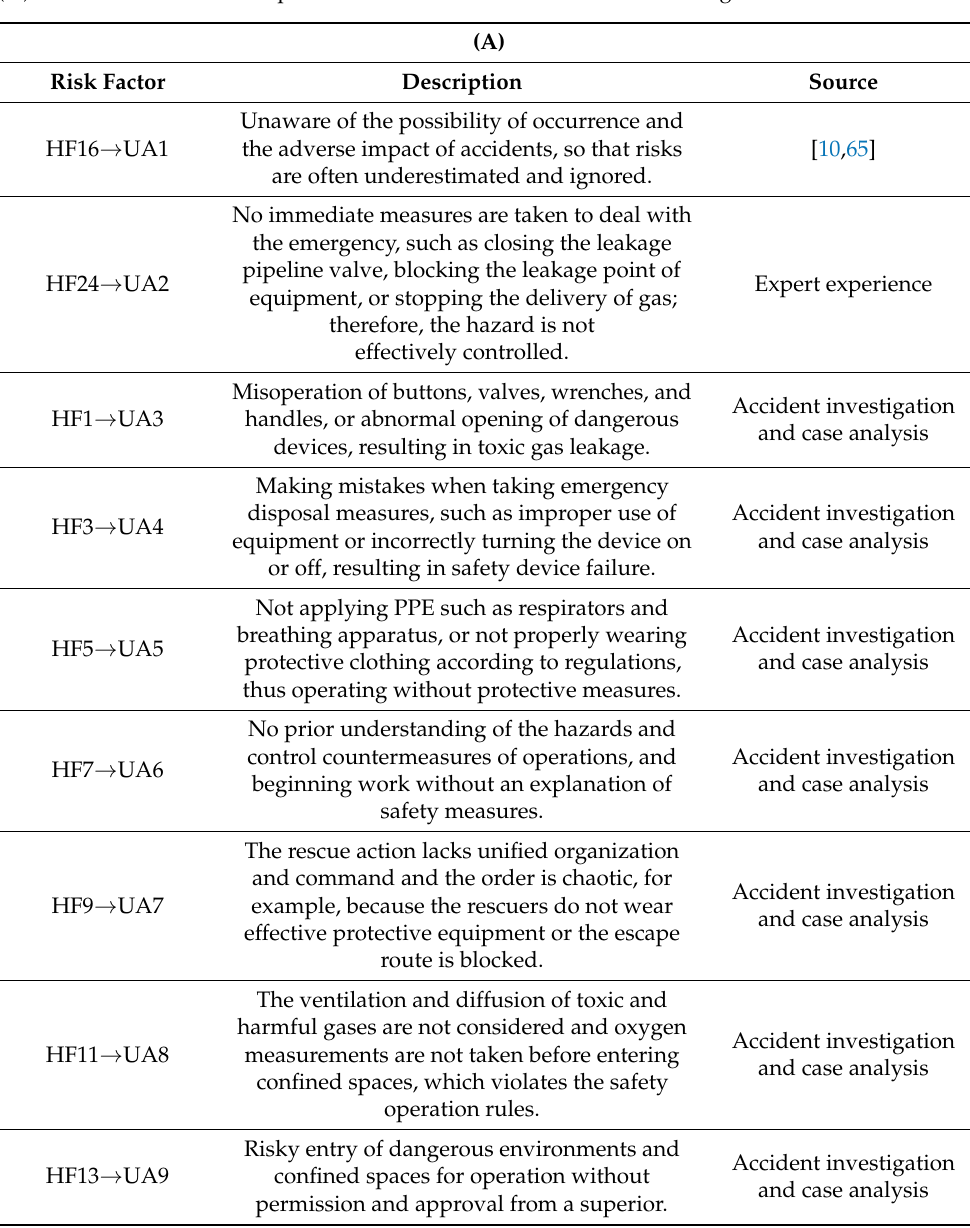
Table 2. ( A ) Identification and description of the human factors under HFACS-Unsafe acts; ( B ) Identification and description of the human factors under HFACS-Preconditions for unsafe acts; ( C ) Identification and description of the human factors under HFACS-Unsafe supervision; ( D ) Identification and description of the human factors under HFACS-Organizational